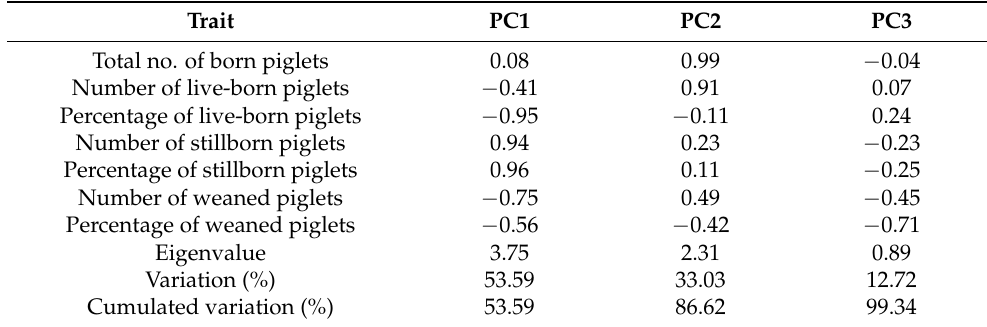
Table 5. PCA for marker SW245 : Eigenvalues, variance explained, cumulative variance explained, and correlation coefficients with the original traits of the first three principal components (PCs). Trait PC1